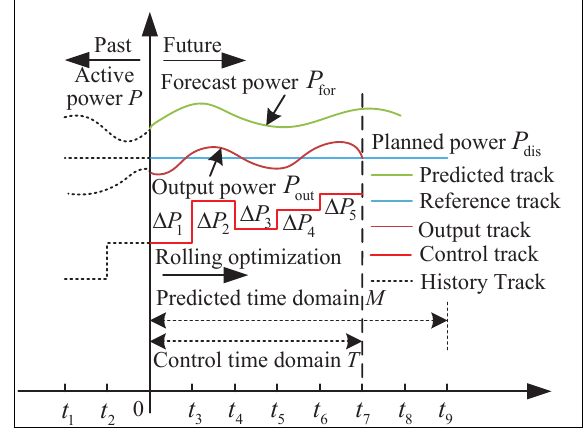
Figure 6. Diagram of rolling optimization in